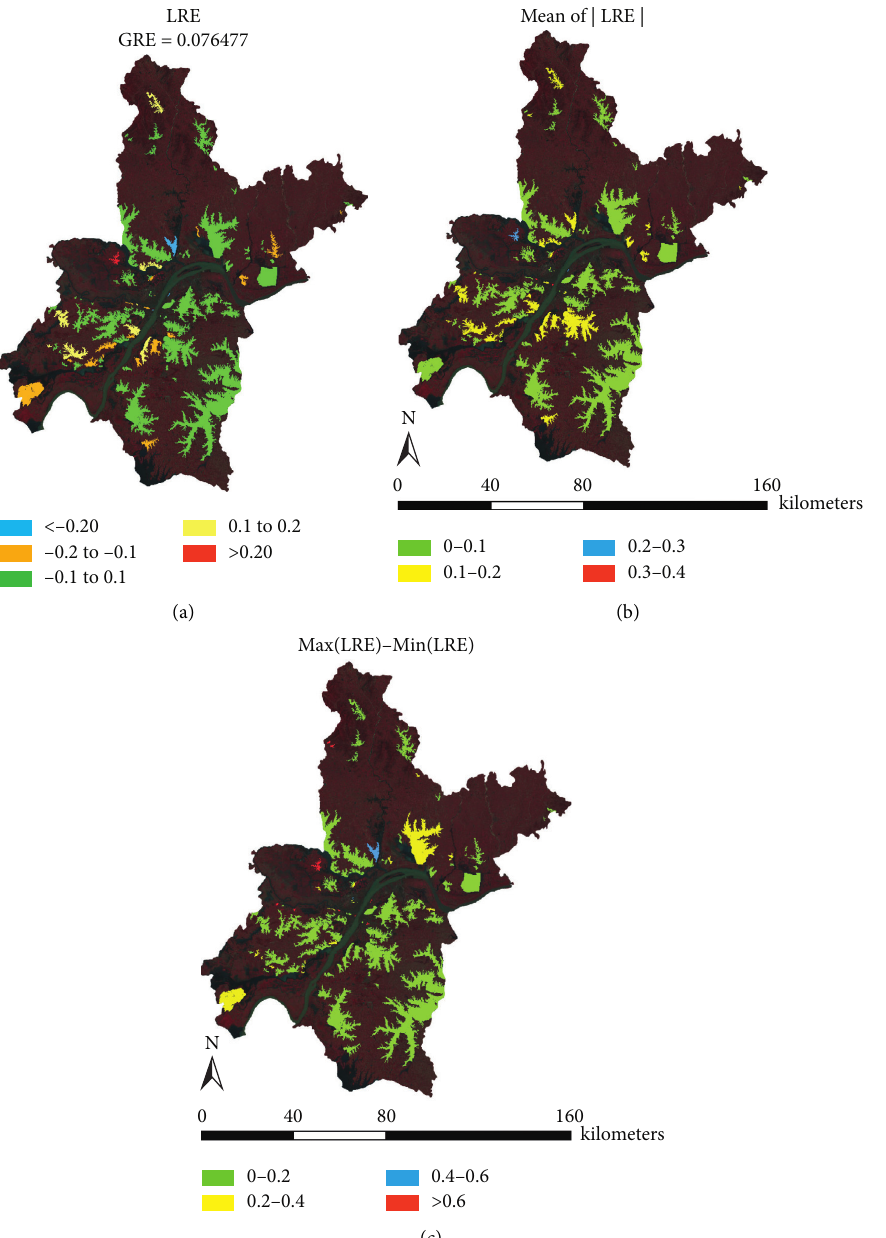
Figure 18: The spatial distributions of (a) LRE, (b) the mean of the absolute values of LRE, and (c) the difference between maximum and minimum of